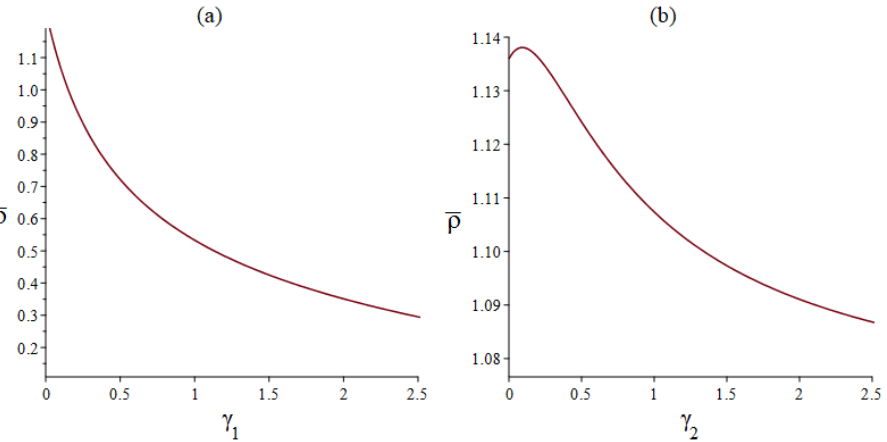
Figure 3. Effect of anthropogenic toxins on maximum amplitude ¯ ρ , where ( a ) γ 2 = 0.02, ( b ) γ 1 = 0.057. (iv) Let D 1 = 0.1, D 2 = 0.05, D 3 = 0.15, τ 1 = 0.5, τ 2 = 0.8, τ 3 = 0.1, γ 1 =